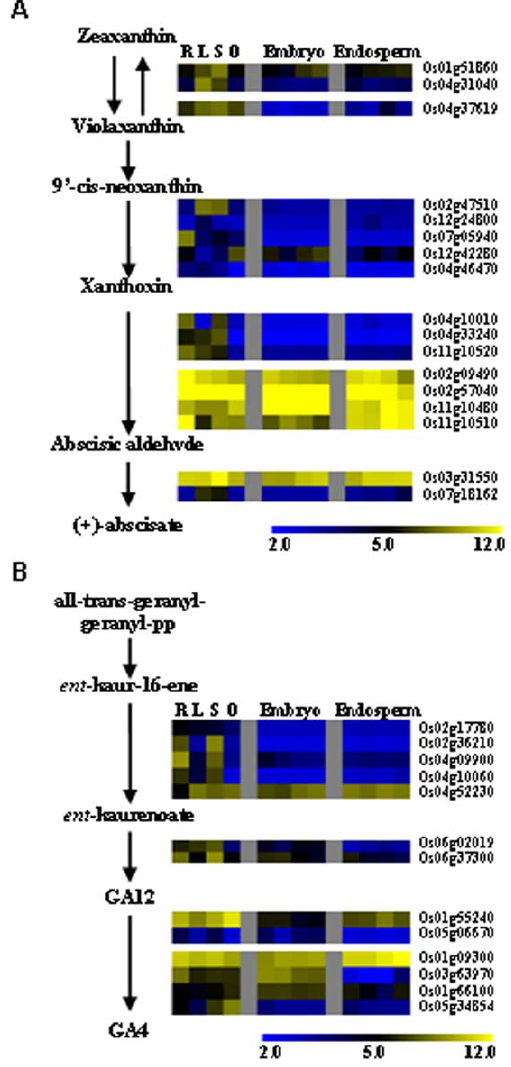
Figure 5. Expression patterns of genes involved in ABA and gibberellin biosynthesis during rice seed development. The ABA (A) and GA (B) biosynthesis pathways were from PlantCyc (www. plantcyc.org) and the expressions of relevant genes were log2 transformed. The expression of genes in root (R), leaf (L), seedling (S), ovary (O), embryo and endosperm were shown. The bar represented the scale of relative expression levels.